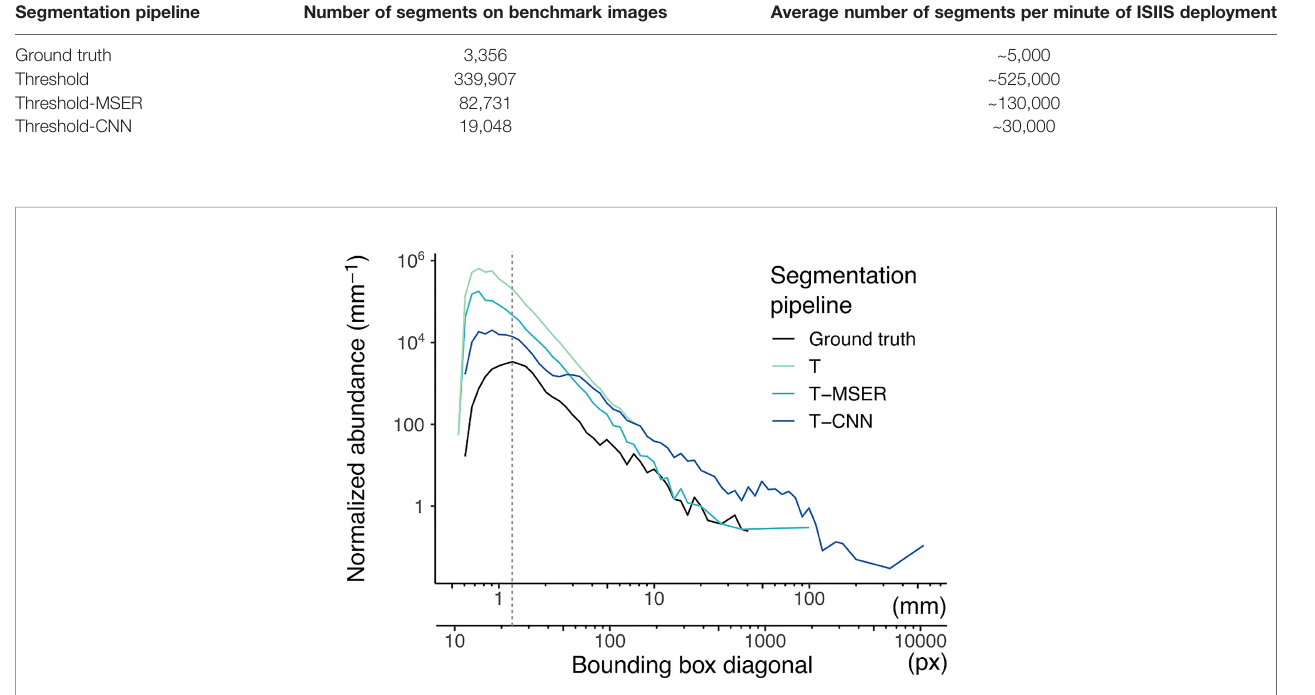
FIGURE 4 | Normalized abundance size spectra (NASS) of all segments generated by the benchmarked pipelines and ground truth segmentation. To compute the NASS, segments were grouped into size classes on a log2 scale, each class size being two times wider than the previous one. Normalized abundance was computed by dividing the number of segments in each class by the size class width, resulting in an adimensional quantity (number of segments) divided by a length (mm here). The double x-axis is the length of the diagonal bounding box displayed both in pixels and after conversion in mm. The dotted vertical line highlights the slope discontinuity in the size spectrum of ground truth segments. Note that both axes use log10 scaling. T, threshold-based; T-MSER, threshold-MSER; T-CNN, threshold-CNN.